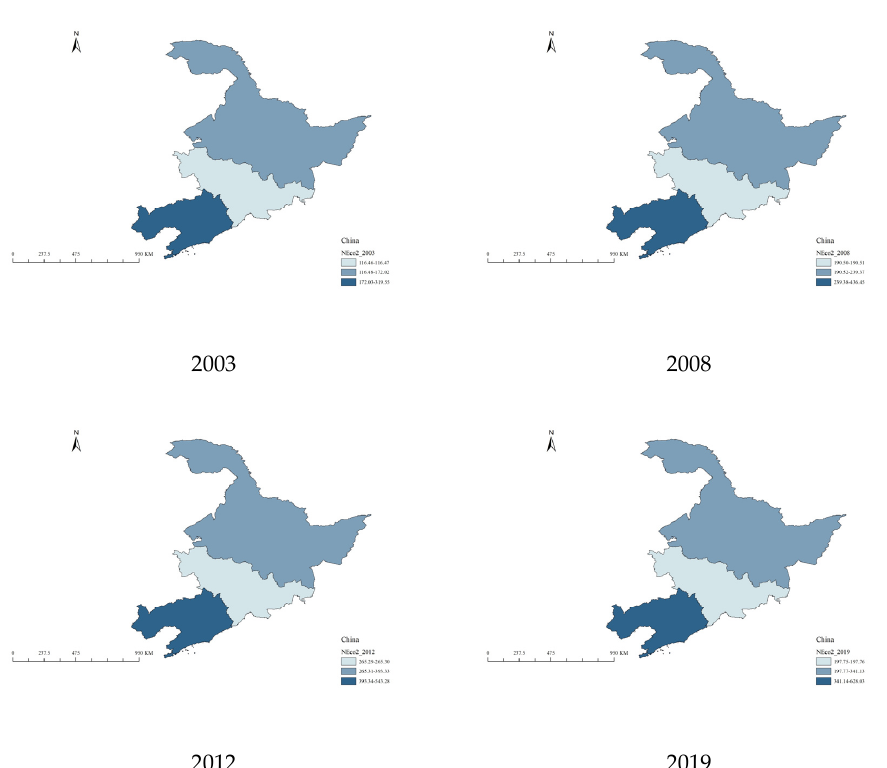
Figure 9. The trend of carbon emission levels in western China.